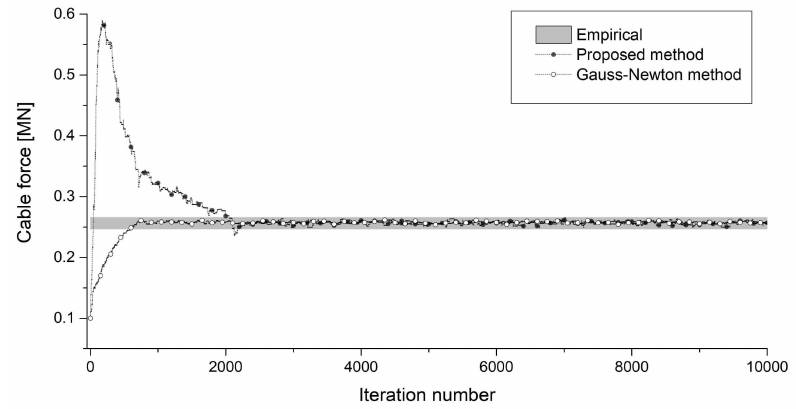
Figure 8. Cable force convergence in the proposed method without predefined model orders and the Gauss-Newton method with predefined